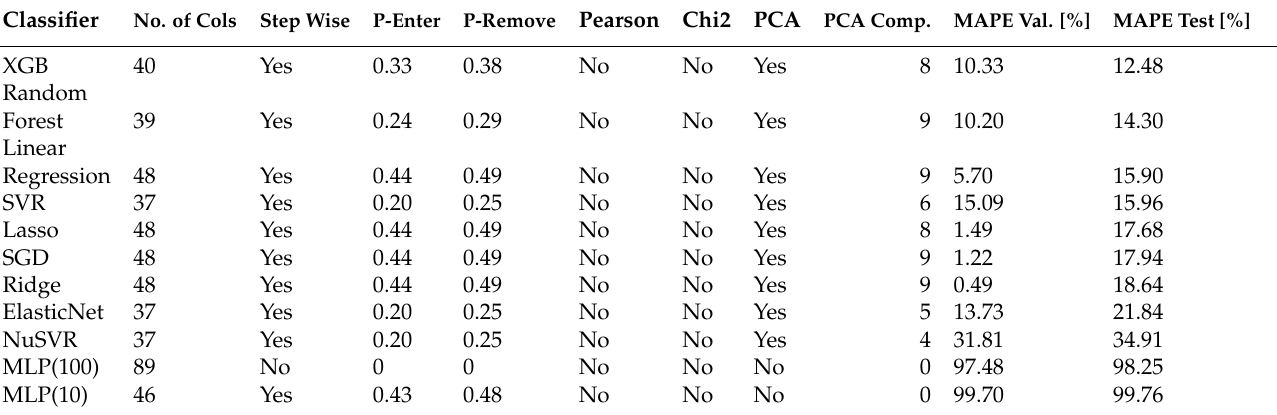
Table 6. Top results of blueberry crop